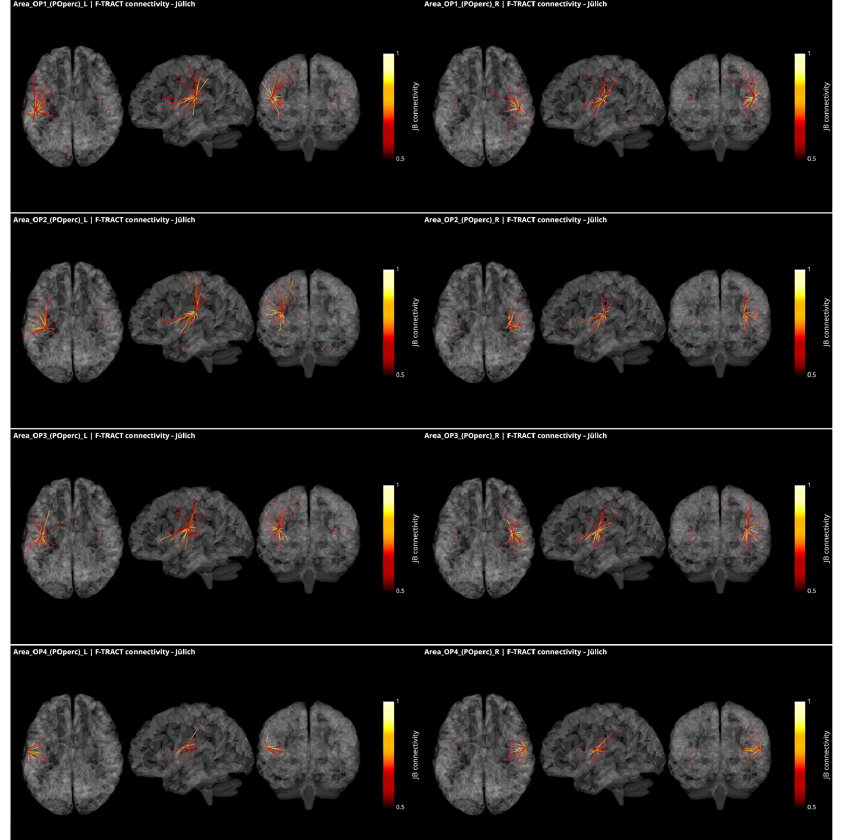
Figure 3. Intracortical connectivity of the four subregions of the parietal operculum from Jülich (‘JB connectivity’ stands for Jülich Brain connectivity). From top to bottom: area OP1, area OP2, area OP3 and area OP4. Left column for the subregions of the left hemisphere and right column for the subregions of the right hemisphere. Image derived from the data of the F-TRACT project (https://f-tract.eu), version of 1 December